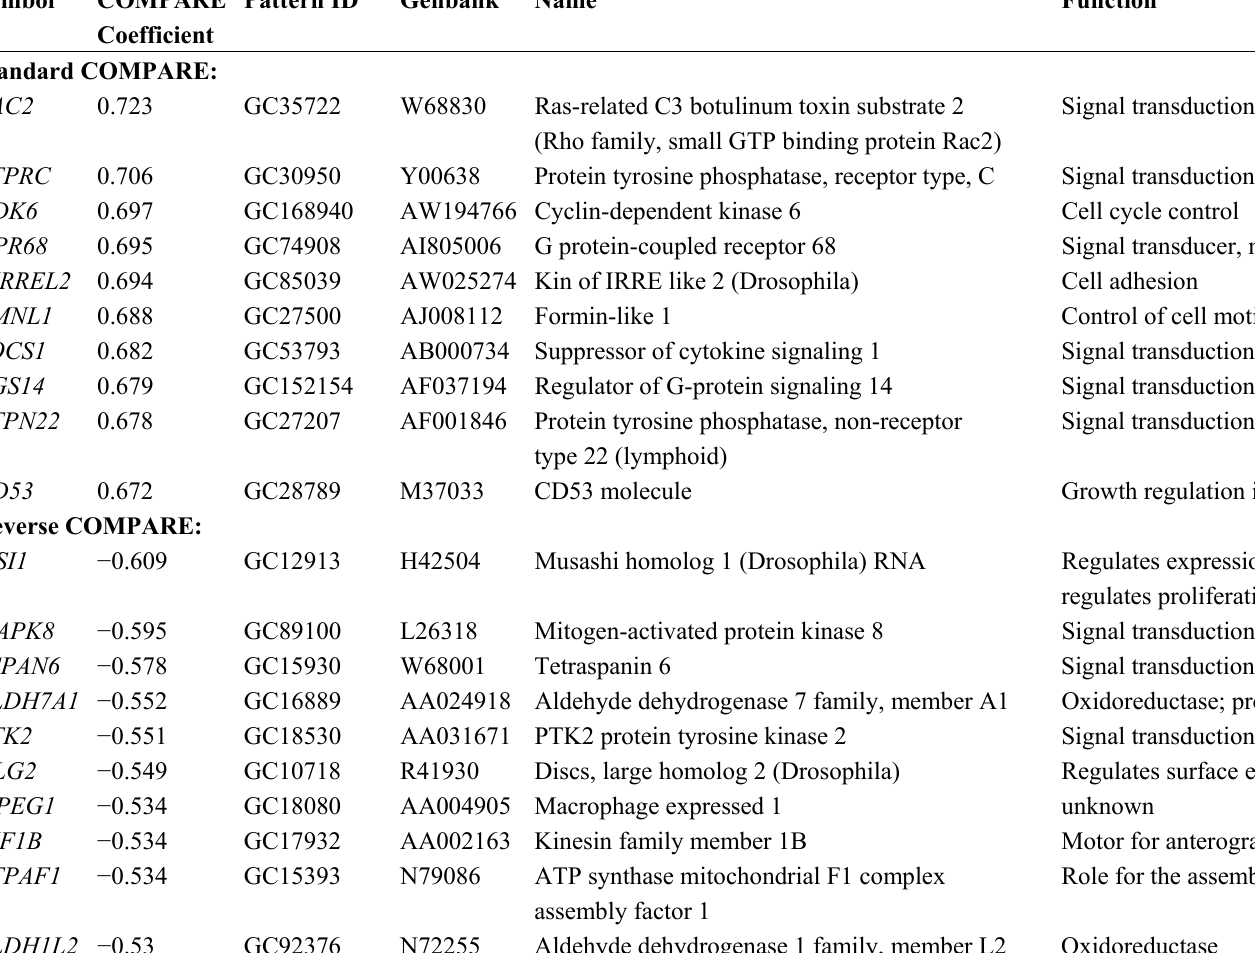
Table 3. Correlation of constitutive mRNA expression of genes identified by COMPARE analyses with log 60 tumor cell